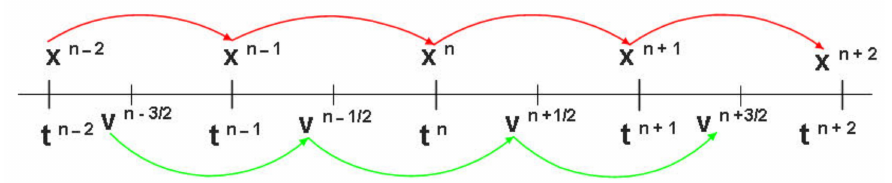
Figure 1. Diagram of the original leapfrog